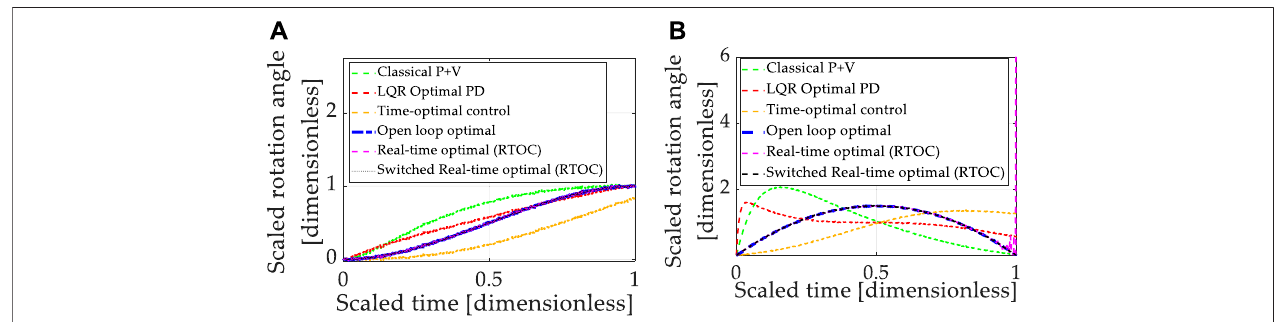
FIGURE6| Double-integratorplant(withtransporttheorem)withcontroldesignbasedondouble-integrator(withtransporttheorem). (A) Motion states (translation or rotational) normalized to propagate from zero and unity in one normalized second. (B) Motion rates (translation or rotational) intended to propagate from zero initial velocity to zero velocity at the endpoint in one normalized second. Notice that the open-loop optimal (minimum) control effort is increased from 6.0 (controlling double- integrators without transport theorem) to just over 7.0 (controlling double-integrators with transport theorem), manifesting as a 17% increase to account for transport theorem over idealized cases of double-integrators